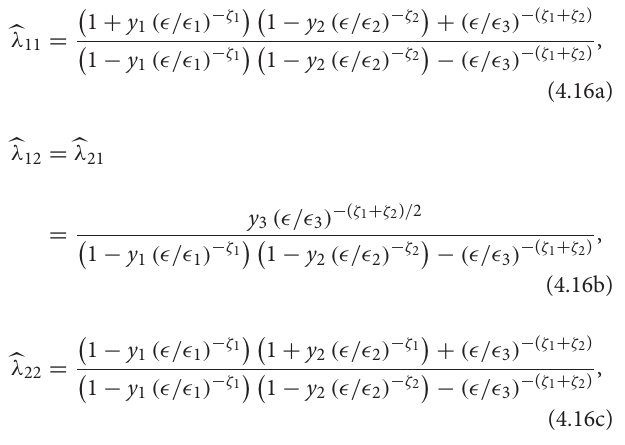
λ 11 vs ζ ln (ǫ/ǫ 1 ) for ζ 1 FIGURE 1 | Plot of ( ǫ 2 /ǫ 1 ) ζ 2 and ( ǫ 3 /ǫ 1 ) ζ 0.02. The fascinating second pole arises in certain = = b limits of the ratio of ǫ 1 to ǫ 2 and ǫ 3 . In the limit ǫ 3 classic single-particle RG.